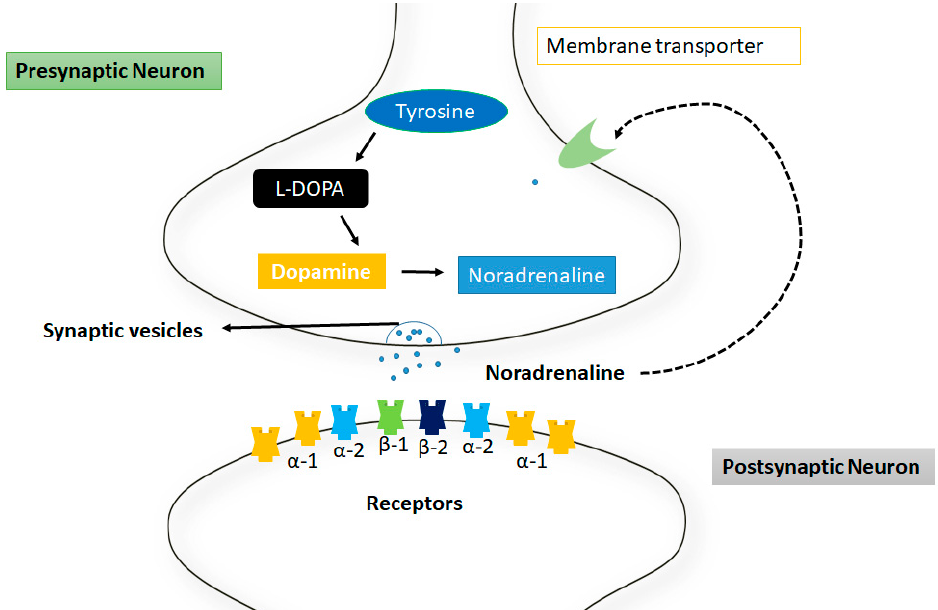
Figure 3. Mechanism of action of norepinephrine at synapsis. The tyrosine is converted into nora- drenaline through intermediates such as L-dopa and dopamine respectively. These neurotransmitters are released from the membrane through synaptic vesicles. There are different receptors represented in different colors at postsynaptic neuron.